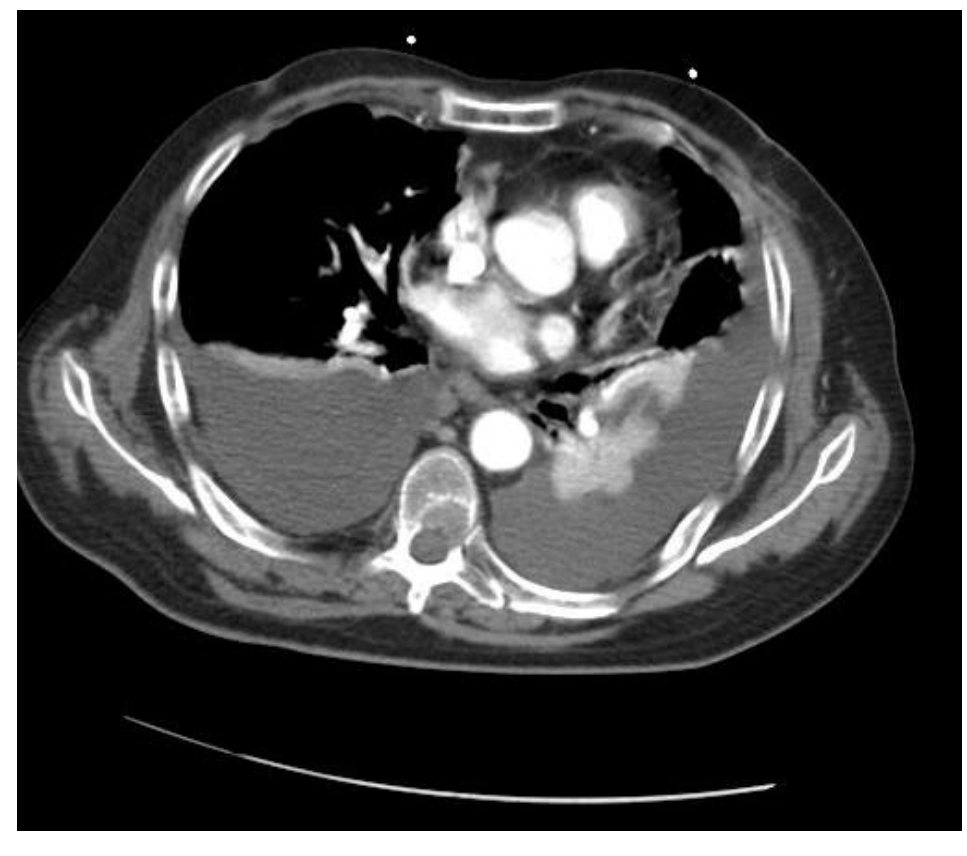
Figure 3. Angio CT-scan showing the metastatic lesions from GBM in the left inferior lobe and in the pleural